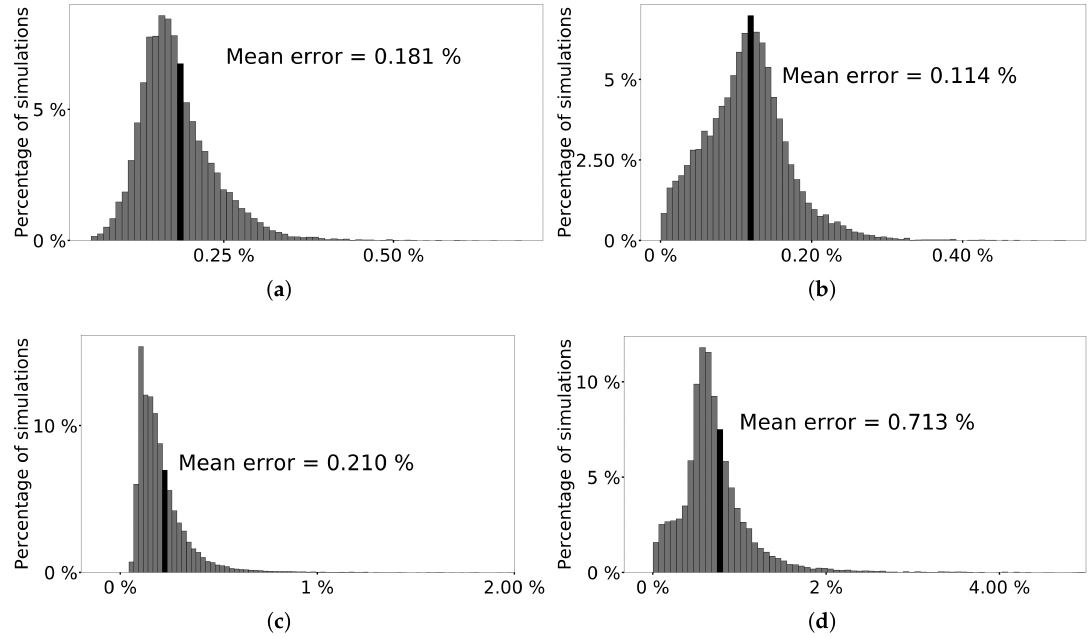
Figure 4. Empirical distribution of the errors for every mechanical variable. ( a ) Empirical distribution for e ε . The size of the histogram bucket is 0.009%; ( b ) Empirical distribution for e ε histogram bucket is 0.008%; ( c ) Empirical distribution for e σ . The size of the histogram bucket is 0.024%; ( d ) Empirical distribution for e p . The size of the histogram bucket is